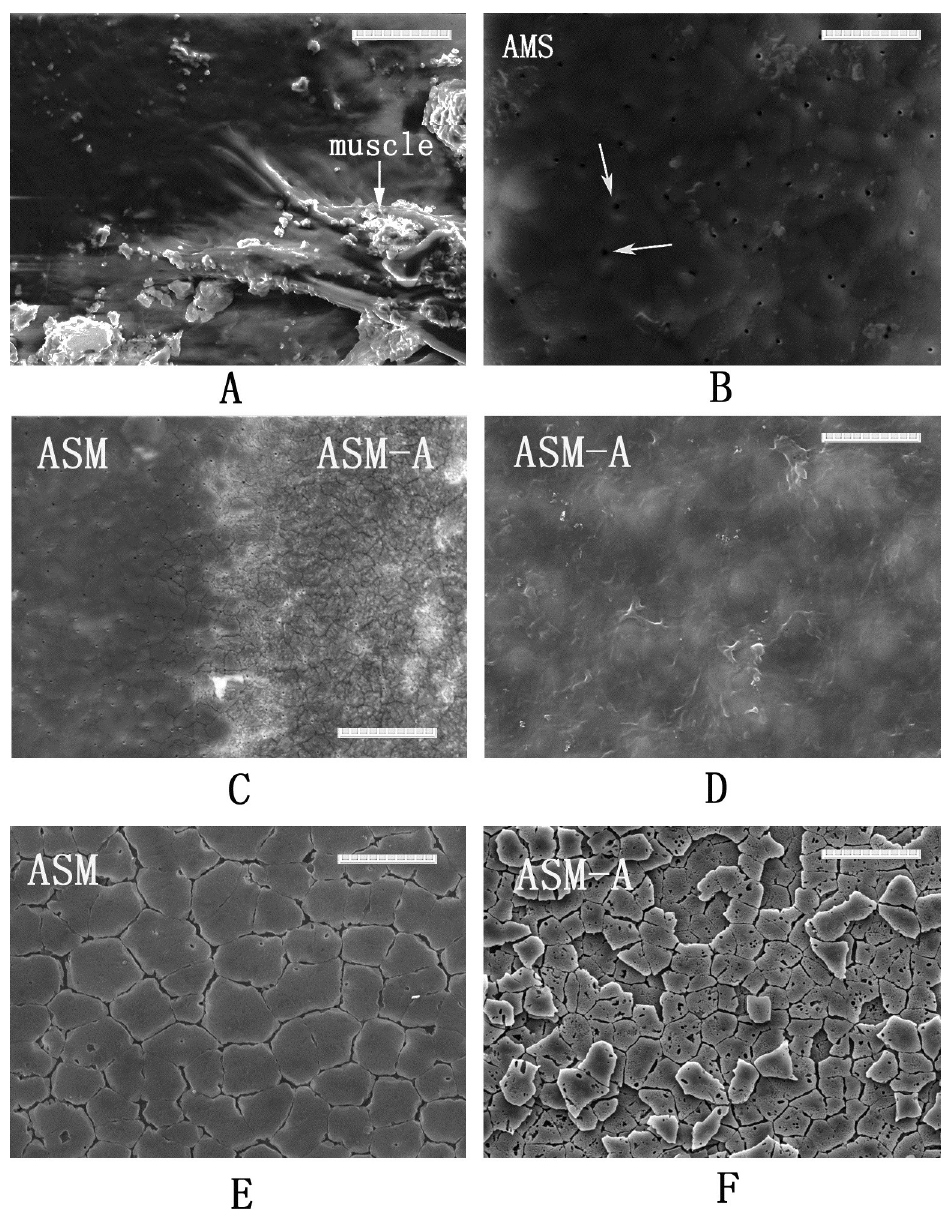
Fig 2. Surface images of AMS and AMS-A region. A : the inner surface image of natural shell of P . viridis at AMS region with the adductor muscle attached; B : the SEM image of surface of AMS region after the adductor muscle removed. The pit structures are denoted by arrows; C : the SEM image of the surface from transition zone between the AMS and AMS-A; D : the SEM image of the surface of AMS-A; E : The SEM image of the AMS surface after deproteinization; F : The SEM image of the AMS-A surface after deproteinization.